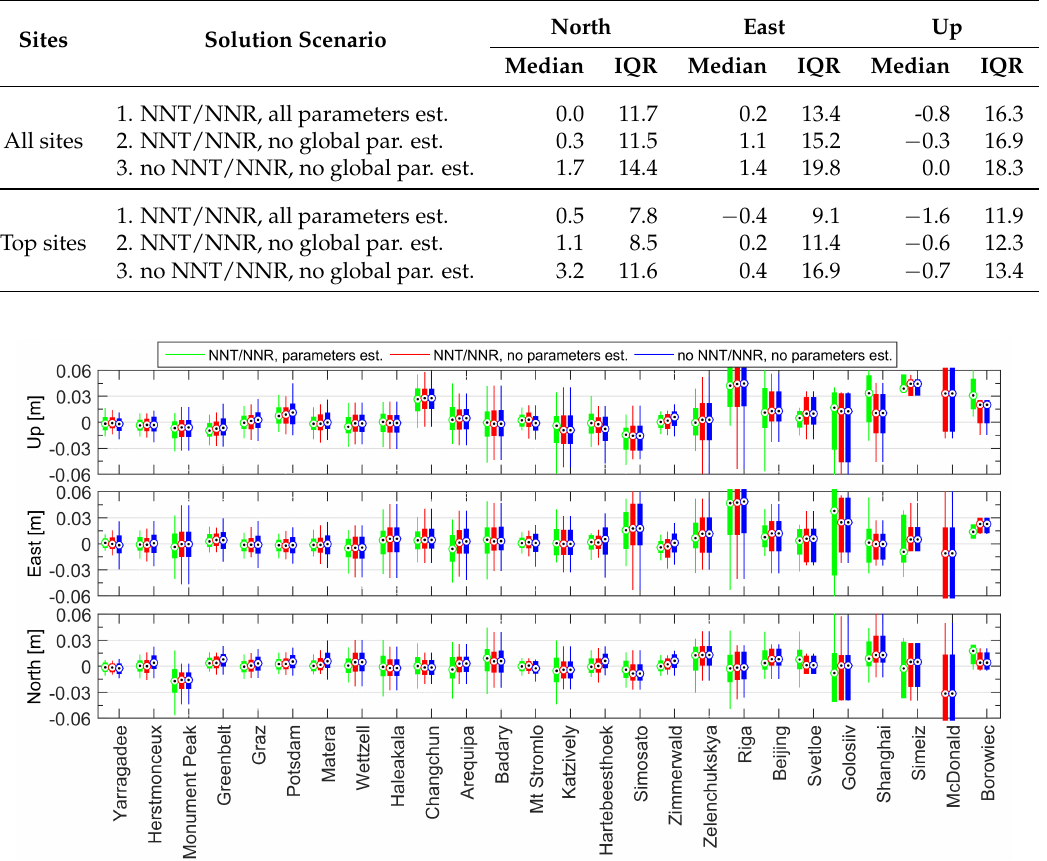
Figure 5. SLR site coordinate repeatabilities in SLRF2014 based on SLR-to-S3A/B data for scenario 1 (green), scenario 2 (red), scenario 3 (blue). Minimum, maximum, 1st and 3rd quartiles and the median value are shown as elements of box-plots. Stations are sorted starting from that with the highest number of 7-day solutions ( left ) to the lowest number of solutions ( right